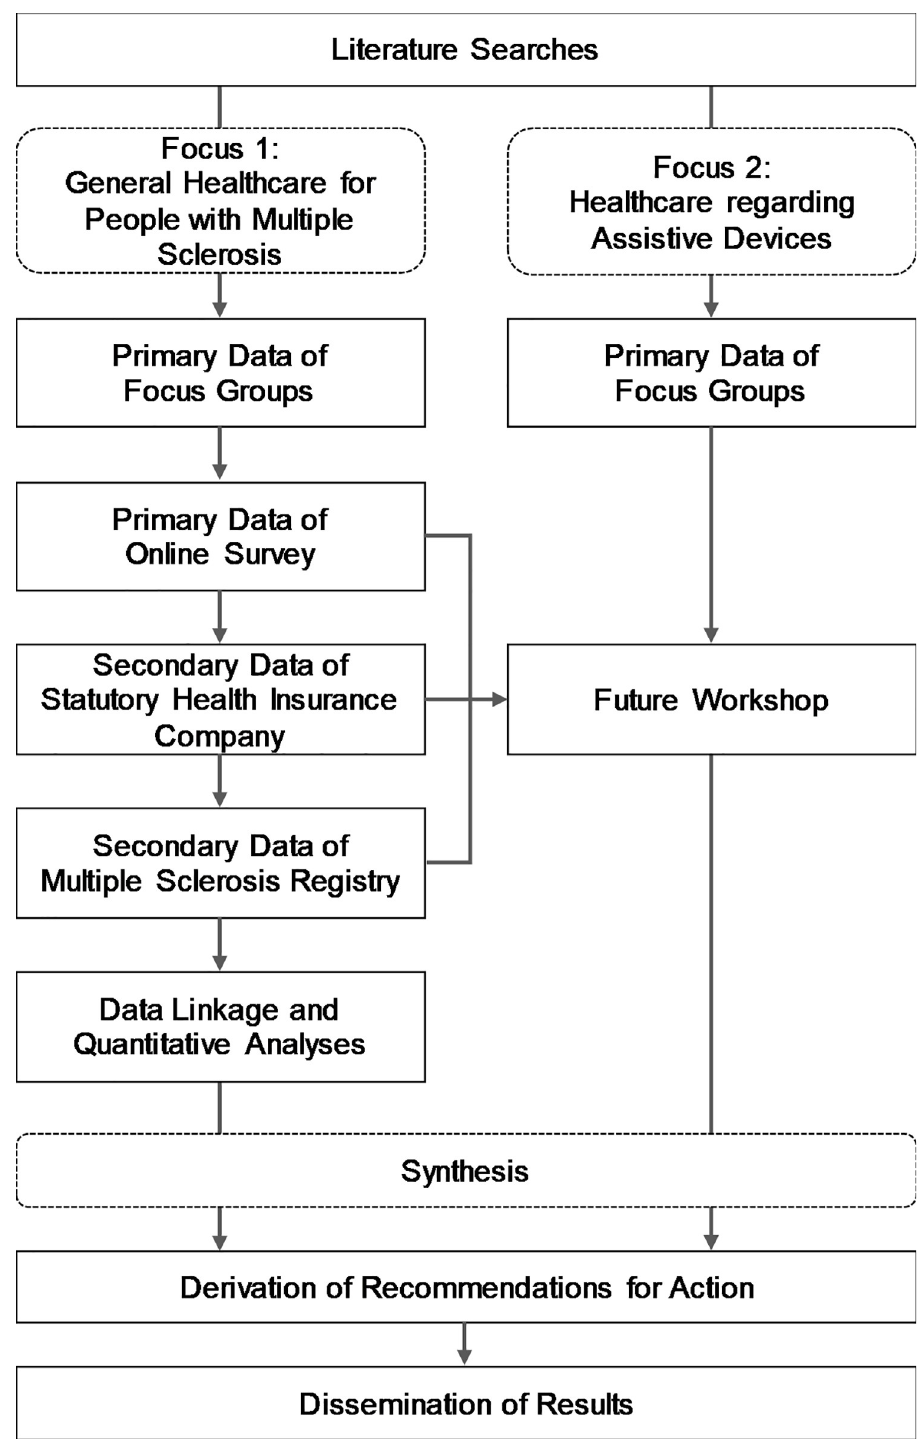
Fig 1. Interaction of data sources and thematic focuses.